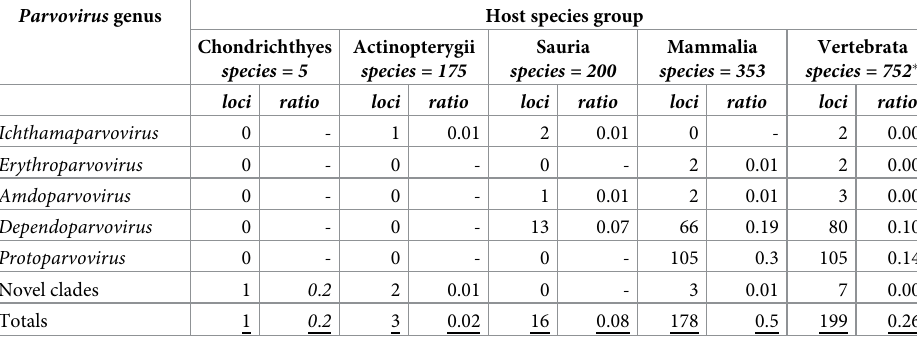
Table 2. Incorporation of parvovirus DNA into the vertebrate